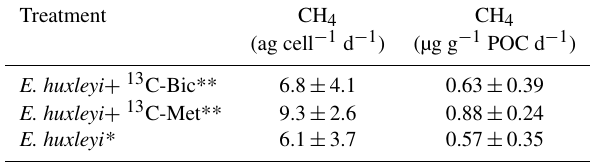
Table 2. Mean daily CH 4 production rates of E. huxleyi (* n = 2; ** n = 3) determined between days 7 and 10; ag: attogramm (10 − 18 ).